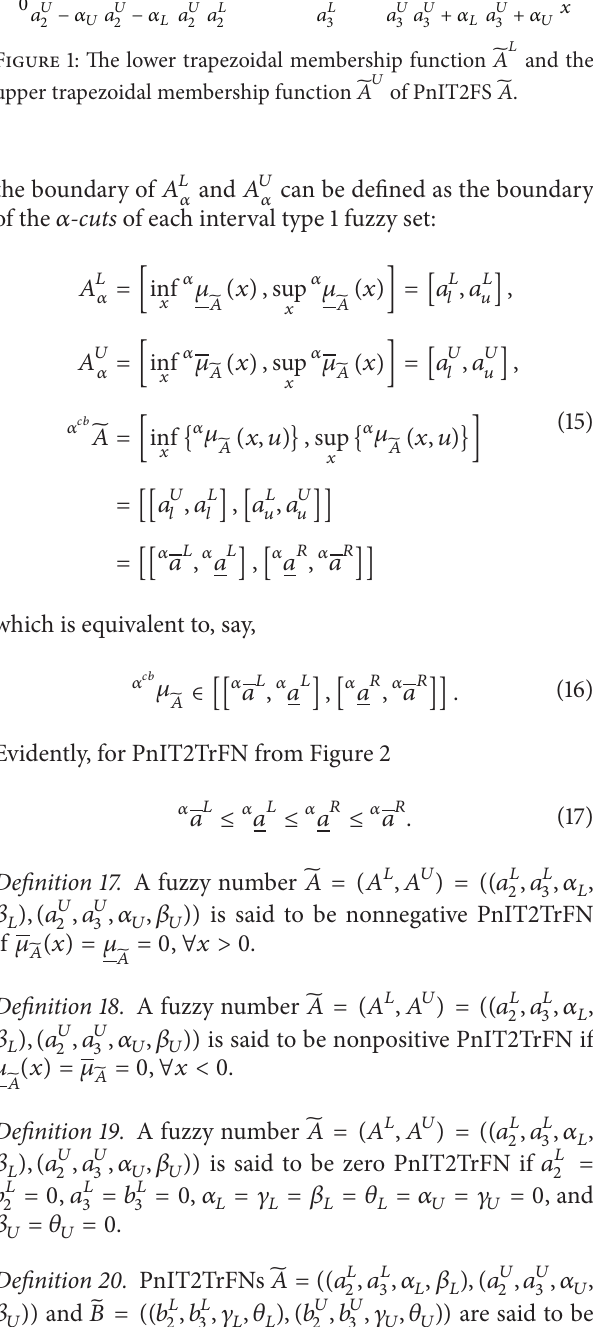
Figure 1: The lower trapezoidal membership function upper trapezoidal membership function